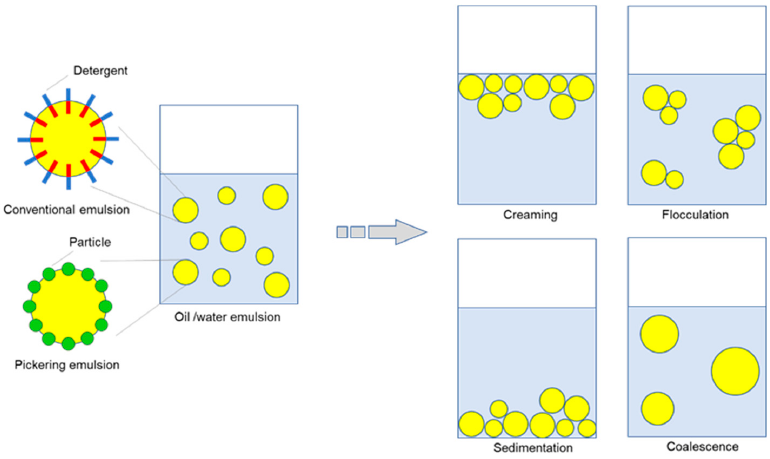
Figure 2. Formation of oil/water emulsion and its four major destabilization patterns. Hemp protein is considered a novel emulsifier in food systems. Dap č evi ć -Hadna đ ev et al. [87] compared the behavior of two types of hemp proteins in the sunflower oil-in- water emulsions. Salt extracted “micellar” hemp protein (HMI) with a less-denatured structure exhibited higher solubility as well as slightly higher surface/interfacial activity than alkali-extracted and isoelectric-precipitated hemp (AIH) protein. HMI formed emul- sions composed of relatively small droplets with enough static repulsion between drop- lets. Individual droplets were covered by protein film. However, low viscosity of HMI- stabilized emulsions facilitated fast droplet movement and eventually led to increased creaming and coalescence at lower protein concentrations (0.25–0.75% w / w ). Meanwhile, AIH exposed hydrophobic sites as well as sulfhydryl groups due to pH-induced unfold- ing of protein structure. In AIH-stabilized emulsions, bridging flocculation occurred dur- ing emulsification by the formation of protein-connected droplet aggregates. However,